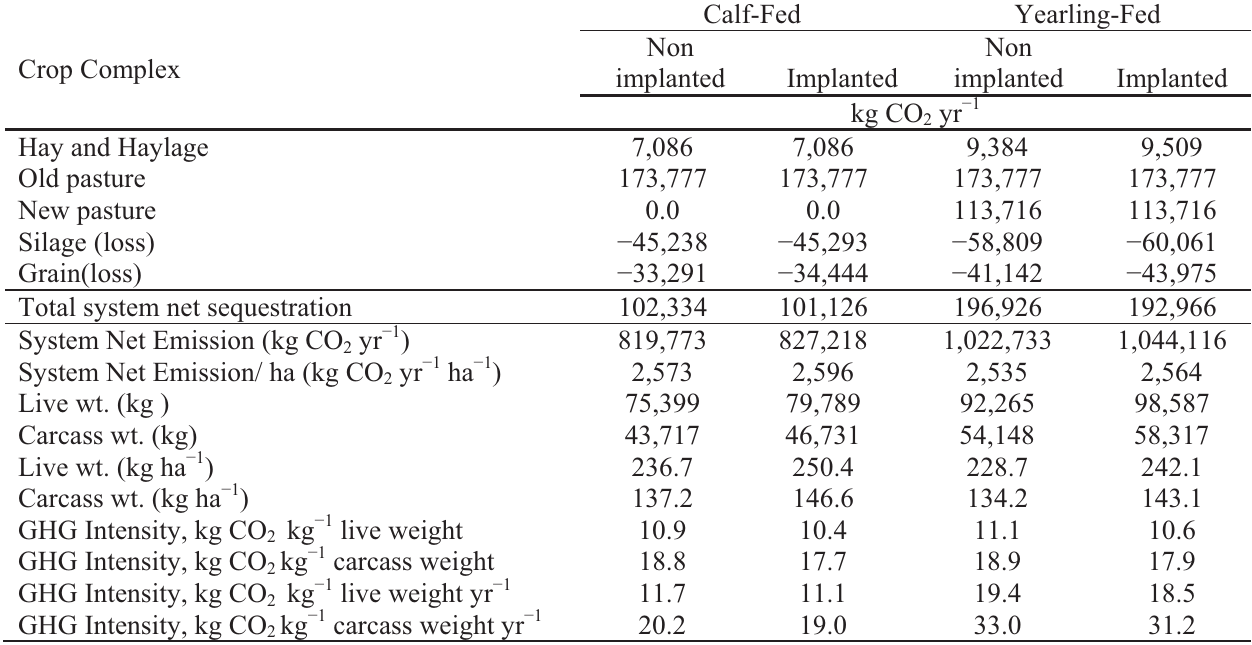
Table A10. Annual sequestration or emission of CO by each system and impacts on system greenhouse emission